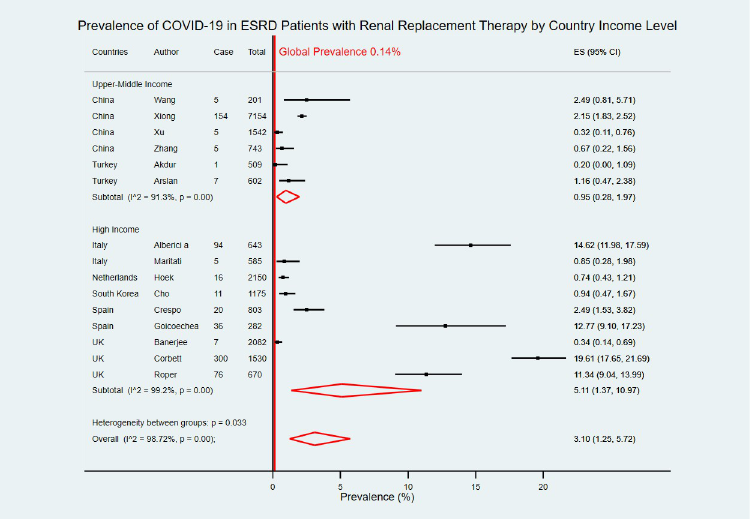
Fig 3. Forest plot of the prevalence of COVID-19 in ESRD patients with RRT by country income level. The figure summarizes the number of COVID-19 confirmed cases in ESRD patients with RRT and the total number of ESRD patients with RRT in 15 eligible studies with subgroup analysis by the World Bank country income level. The forest plot represents the estimated prevalence of COVID-19 in ESRD patients with RRT for each study (black boxes), with 95% confidence intervals (95% CI; horizontal black lines). The estimated pooled prevalence for each subgroup was presented with a red diamond. The overall estimated pooled prevalence (last red diamond) was 3.10% (95% CI 1.25– 5.72). The global average prevalence (vertical red line) was 0.14%. The meta-analysis used a random-effects model with the exact method for confidence interval estimation. ES, effect size. I 2 , test for